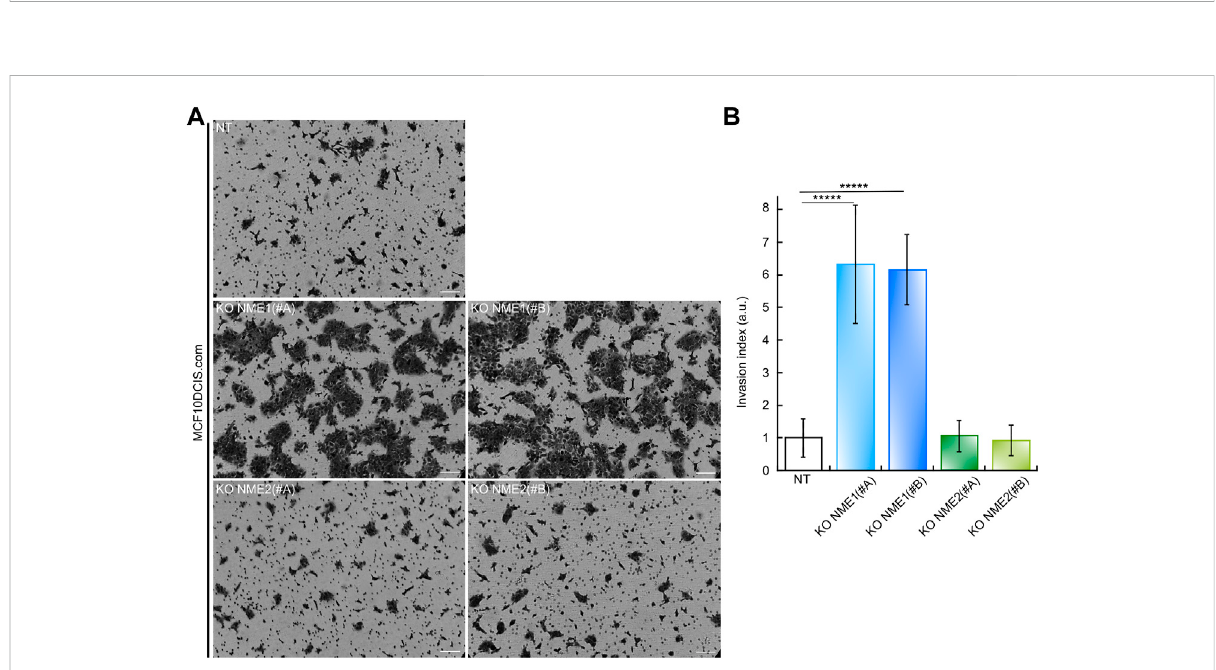
FIGURE 3 Inactivation of NME1 promotes invasion through Matrigel. (A) Representative light microscopy images of Matrigel invasion assay of MCF10DCIS.com cells in which NME1 or NME2 was inactivated after 24 h. (Scale bar: 100 μ m) (B) Quantitative analysis of the invasion assay presented in (A) . The data show the means ± SEM of three independent biological replicates imaged and are expressed as an invasion index de fi ned as the ratio of the number of invading NME1-ablated cells or invading NME2-ablated cells on the number of invading NT control cells. By de fi nition, the invasion index of NT control cells is 1. ***** p < 0.00001 relative to NT control